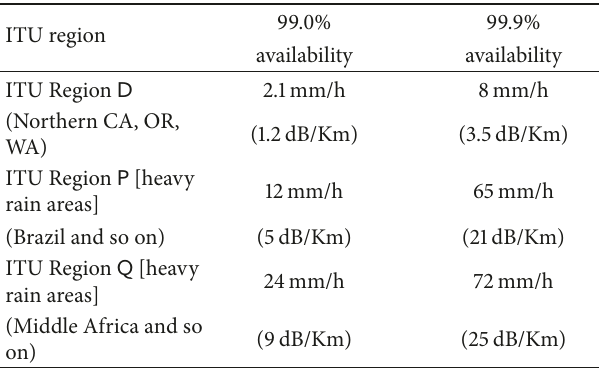
Table 2: Rain rates (unit: mm/h, i.e., millimeter per hour) and their corresponding attenuation factors (unit: dB/Km, i.e., decibel per kilometer) at 60 GHz depending on rain climatic zones (especially for ITU Regions D , P , and Q ) [14].